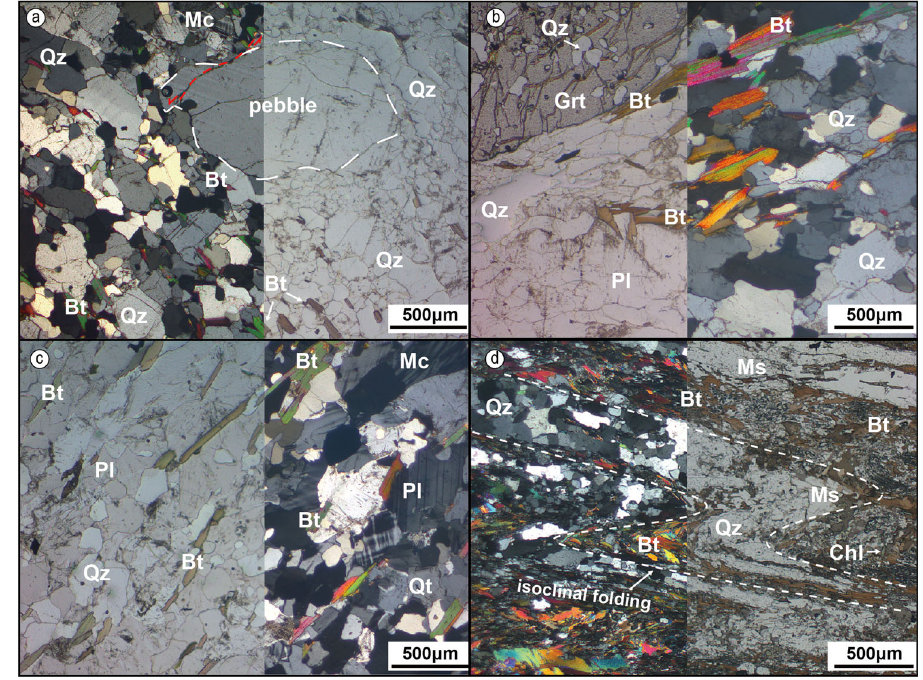
Fig. 6 | Microscopic image of the geochronological samples. a 21YY-3, unit 2 basal (meta)sandstone, white dash line shows the pebble within the (meta)sand- stoneindicatingpoor-sorting. b 19ZK-567,unitthreehighergreywacke. c 19ZK-024,